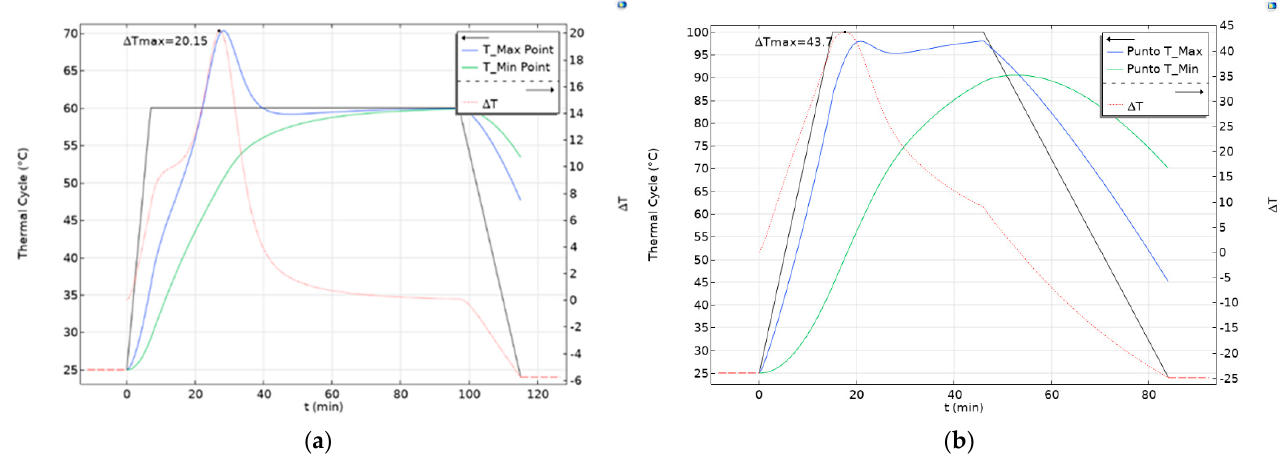
Figure 17. Temperature profile inside the part for the hottest and coldest points and their gradient for the cycle at Tmax equal to 60 °C ( a ) and 100 °C ( b ) in the high thermal flow environment case. Table 5. Summary of predictions as function of manufacturing